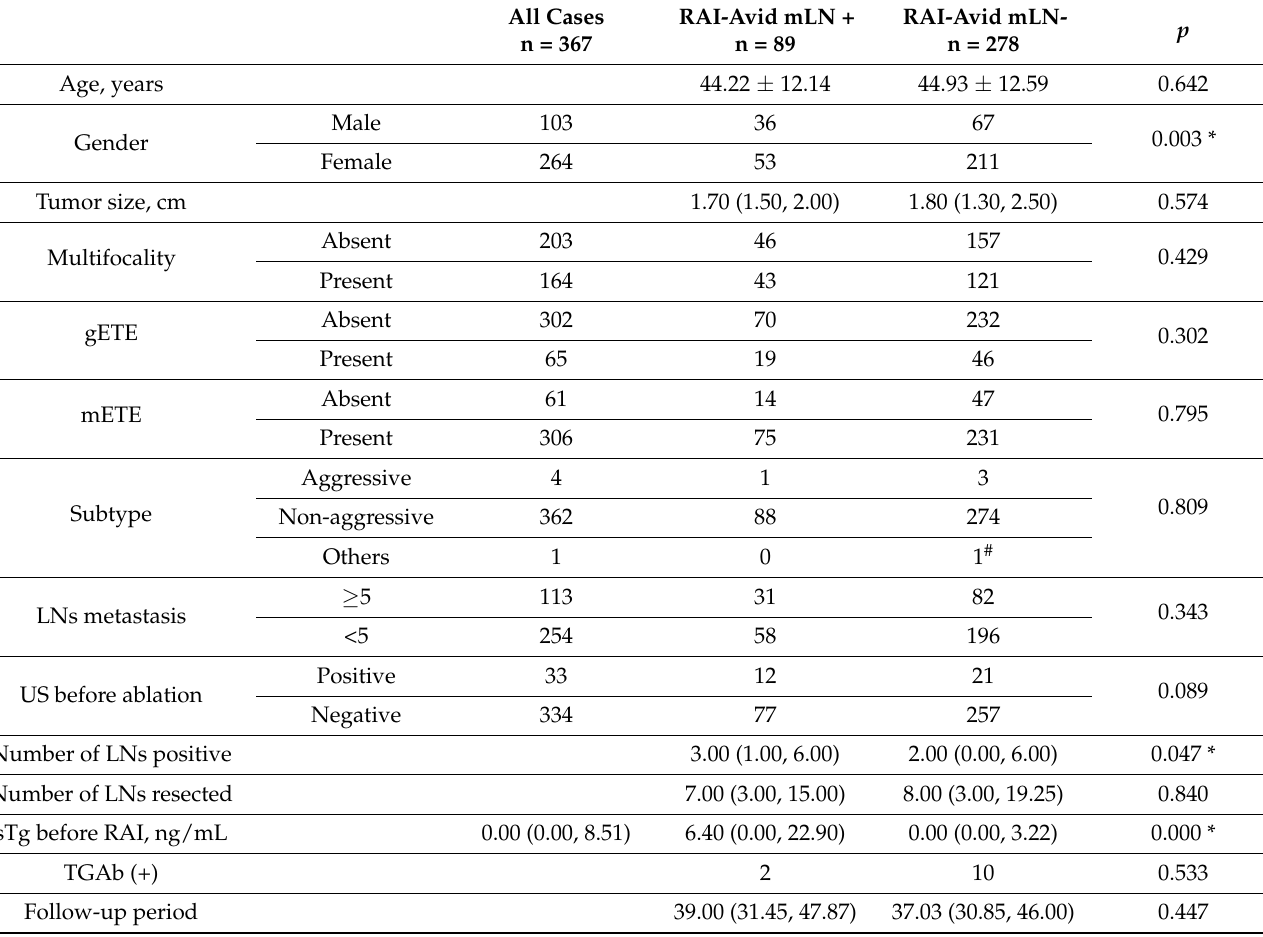
Table 1. Patient